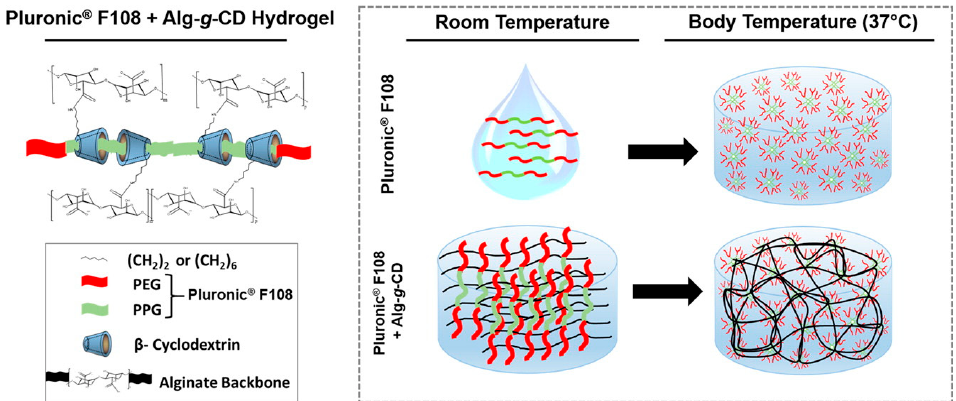
Figure 6. Physical cross-linking between Alg- g -CD macromolecules and Pluronic ® F108 ( left ) and the thermo-response of the hydrogel network ( right ). Pluronic ® F108 forms micelles and self-cross-links at body temperature. β -CD (host) conjugated onto the alginate backbone (Alg- g -CD) formed a physically cross-linked supramolecular inclusion complex with the guest, the PPG block (green) of Pluronic ® F108. Reprinted with permission from [111]. Copyright 2016 American Chemical Society.